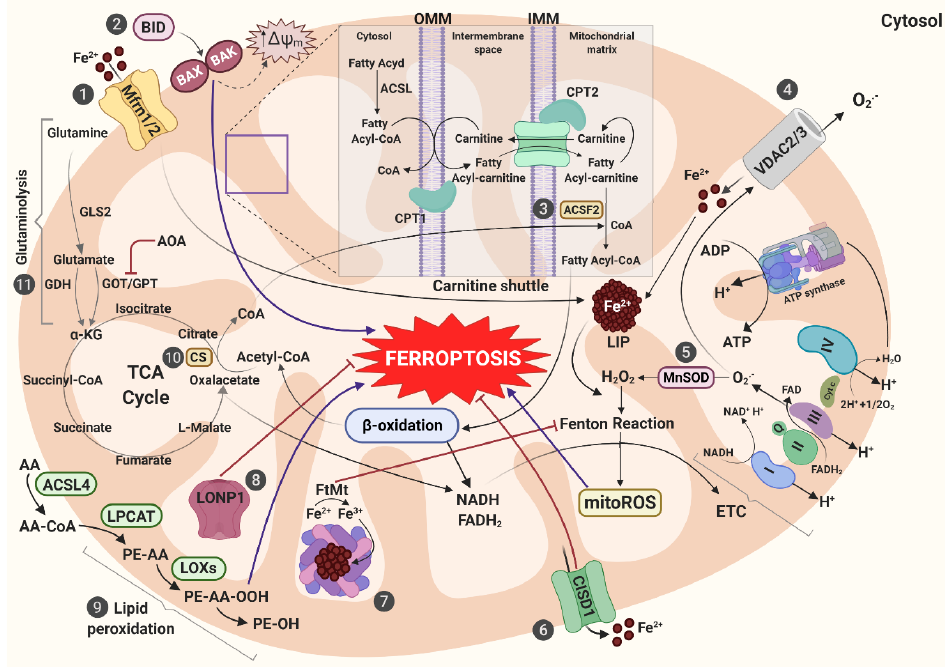
Figure 3. Mitochondrial metabolic processes in ferroptosis. 1) Iron uptake via Mfrn1/2 increases LIP amount, promoting mitoROS generation through Fenton Reaction. 2) BID triggers ferroptosis through BAX and BAK activation and the consequent dysregulation of ΔΨ m . 3) ACSF2 regulates activation of